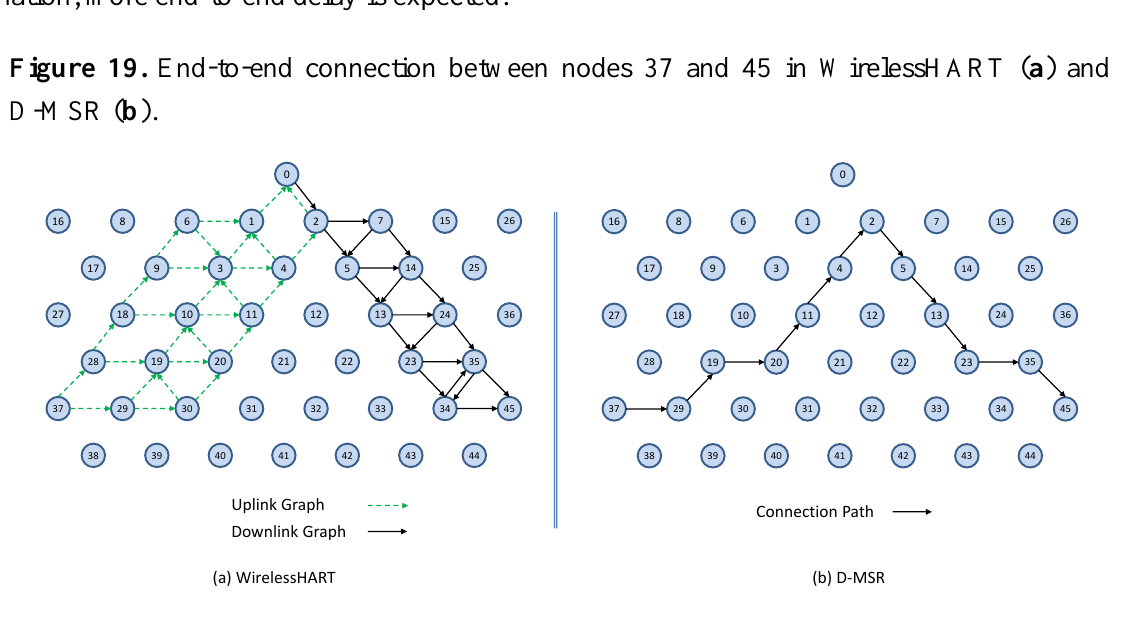
Figure 20. Average end-to-end hop distance ( a ) and delay ( b ) (D-MSR vs.